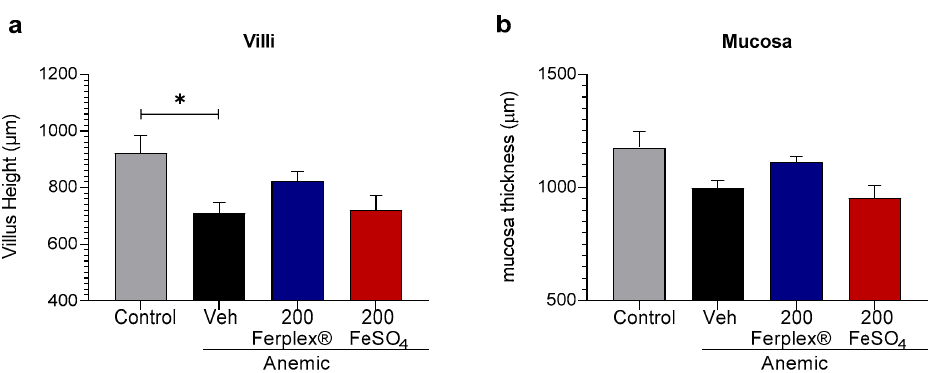
Figure 6. Histological HE analysis of villi ( a ) and mucosa ( b ) height in duodenal samples. Data are presented as individual points and mean ± SEM. * p < 0.05 with the Kruskal-Wallis test followed by Dunnett’s multiple comparison test. N = 6 (anemic-vehicle); 8 (control); 7 (treatment groups). Veh = vehicle.